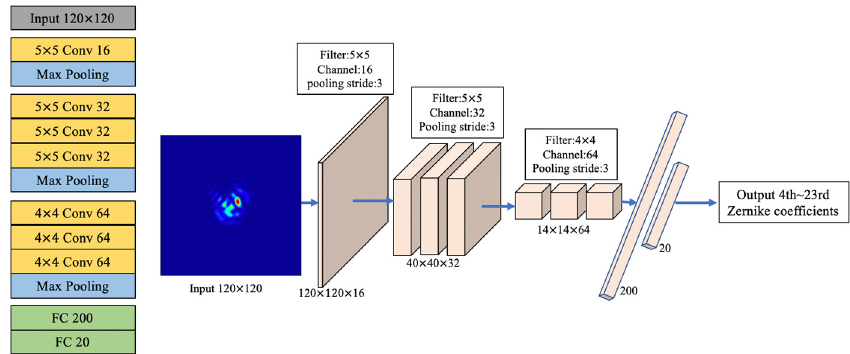
Figure 3. CNN architecture.